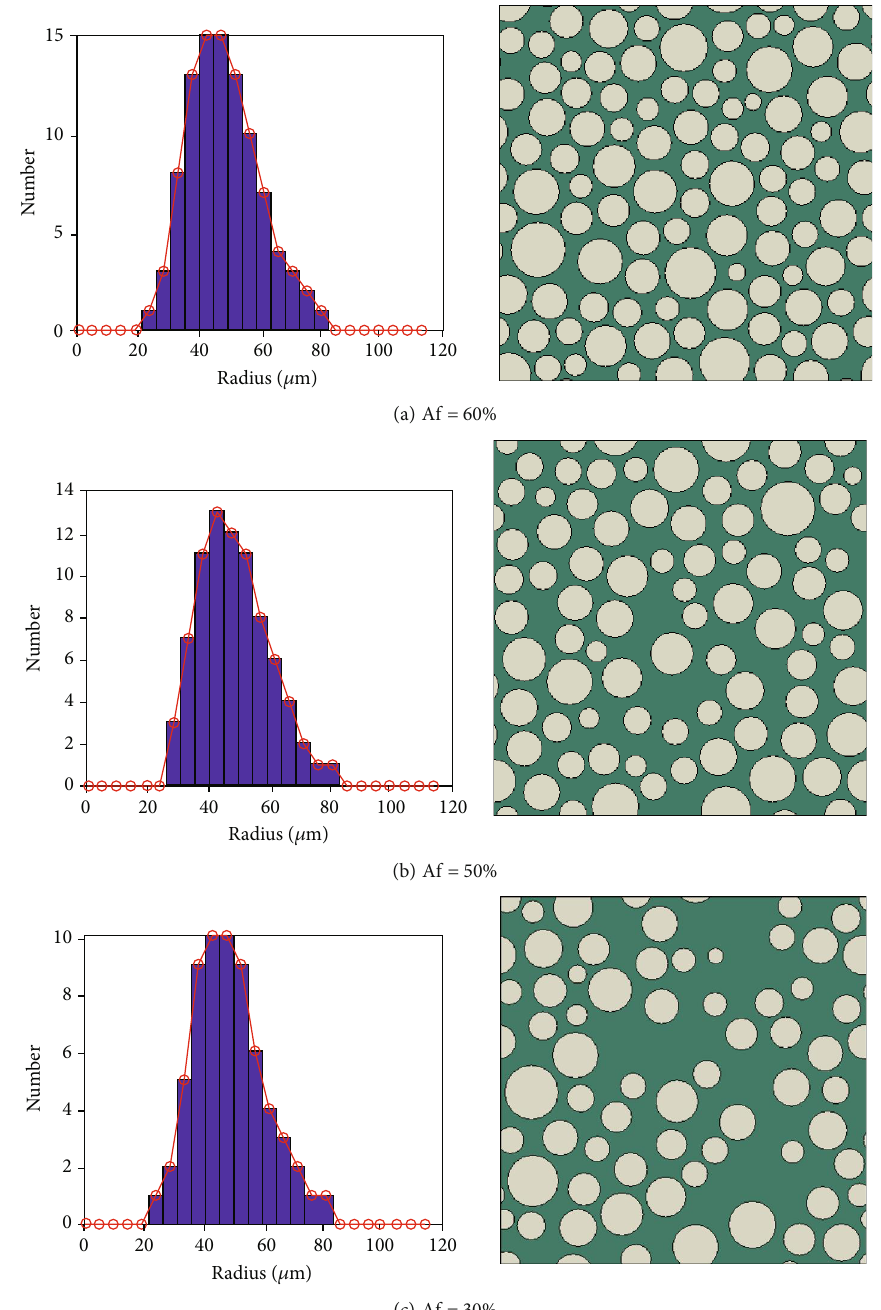
Figure 1: Distribution of the radius (left) and the packing model in the RVE (right) with di ff erent